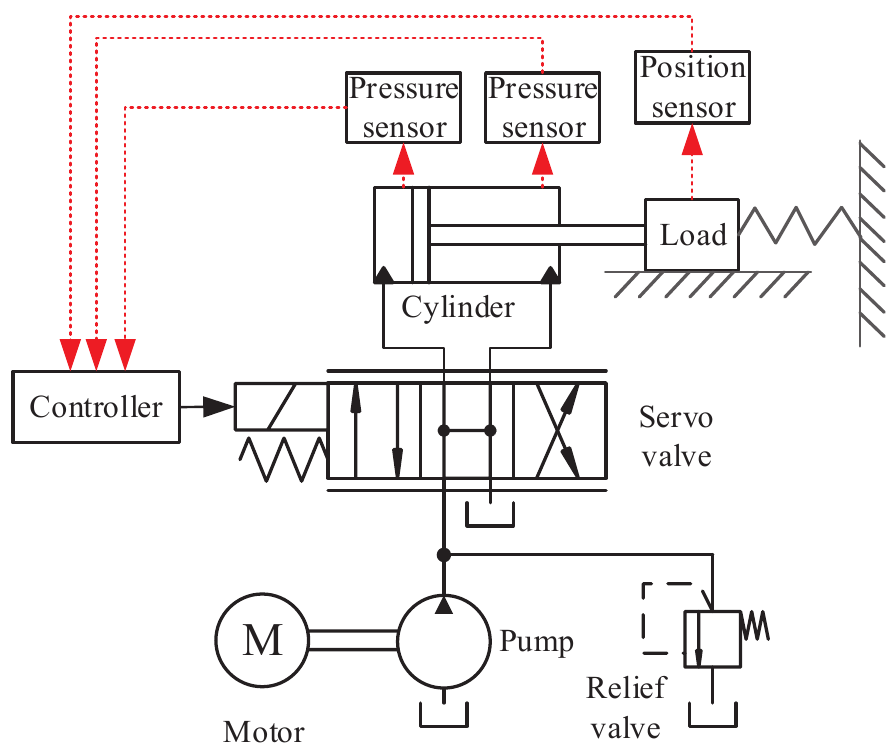
Figure 1. Electro-hydraulic servo system model